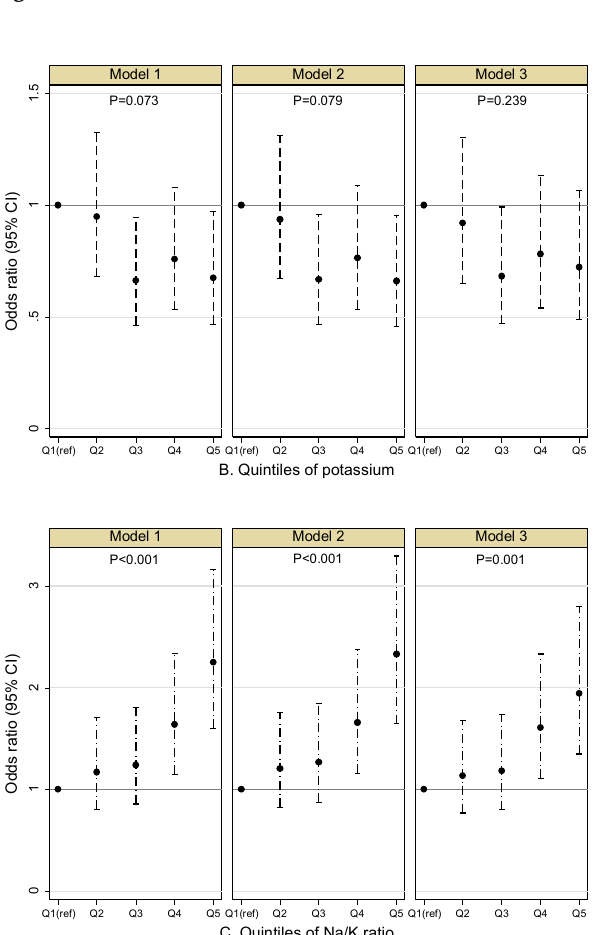
Figure 3. ( A – C ) Odds ratio and 95% confidence interval of albuminuria at each quintile of urinary